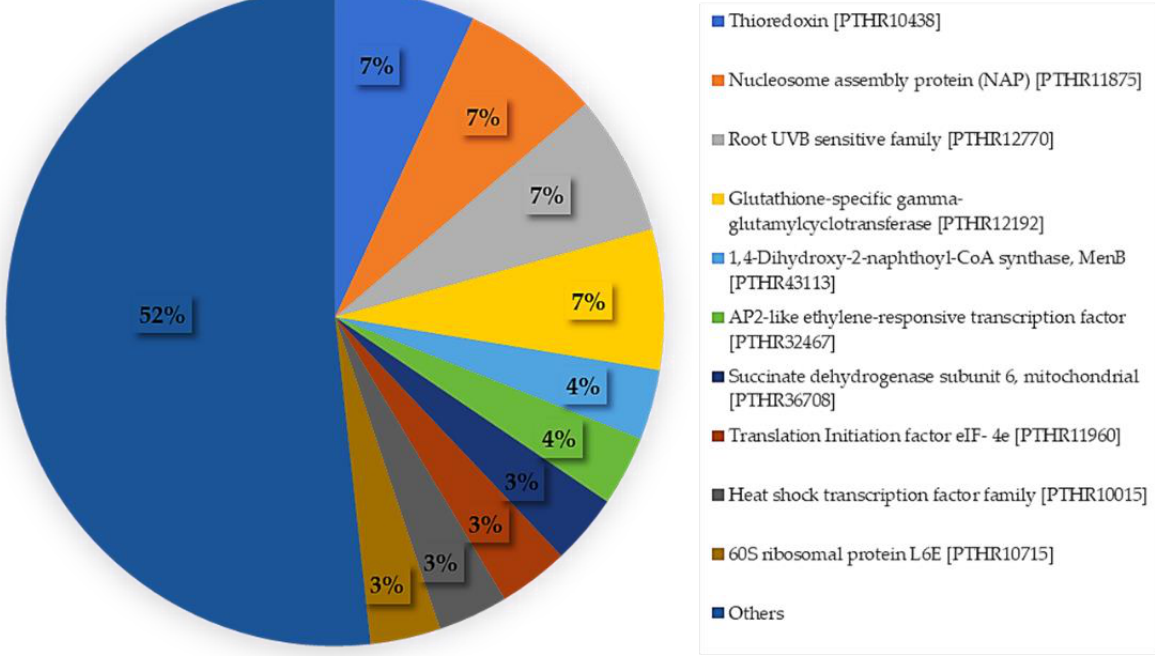
Figure 2 . Distribution of protein function compared between the InterPro Scan and Panther data- bases .